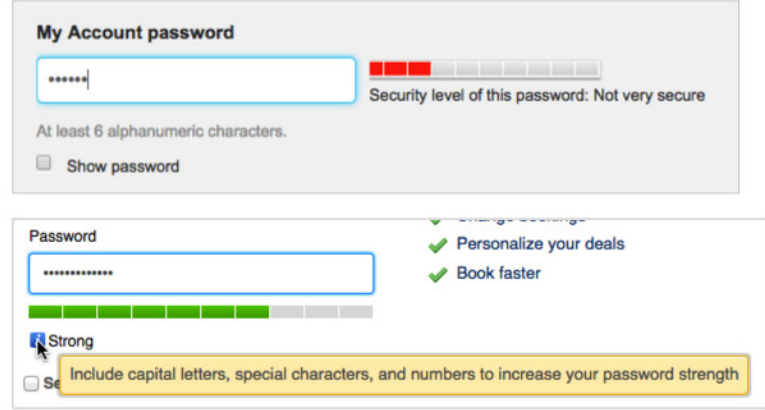
Figure 1. Typical password